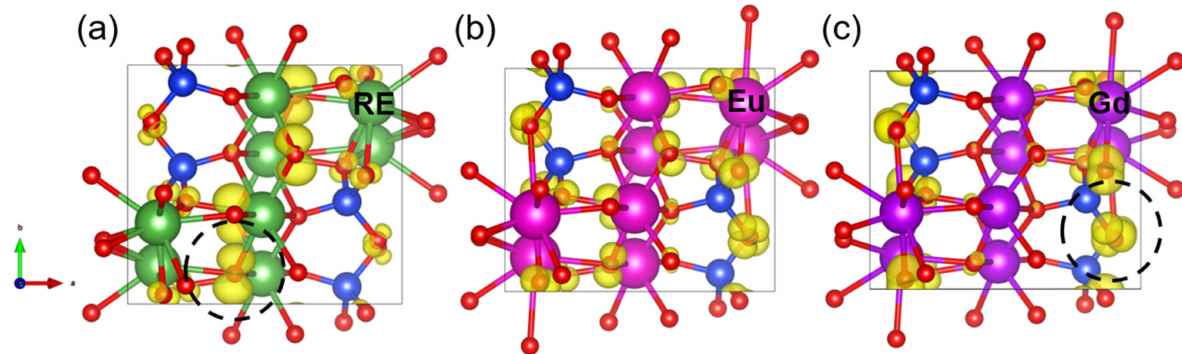
Figure 3. The valence band maximum (VBM) of X1-RE 2 SiO 5 . ( a ) X1-RE 2 SiO 5 (RE = La, Pr, Nd and Sm). ( b ) Eu 2 SiO 5 . ( c ) Gd 2 SiO 5 . Si atoms (blue) and O atoms (red) are shown. RE atoms (RE = La, Pr,